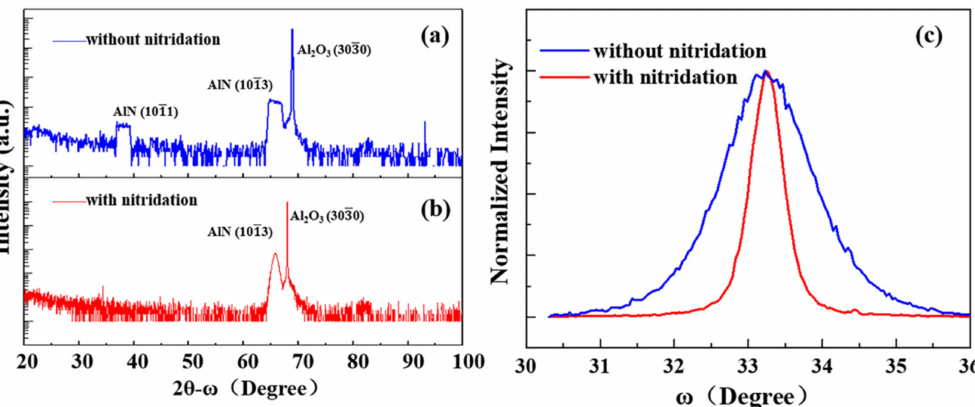
Figure 1. Wide 2 θ - ω scans of sample ( a ) without nitridation and ( b ) with nitridation at 1400 ◦ C. ( c ) Normalized X-ray rocking curve (XRC) of sample taken along AlN [ . The red and blue curves represent the sample with and without 1210 ] nitridation, respectively.